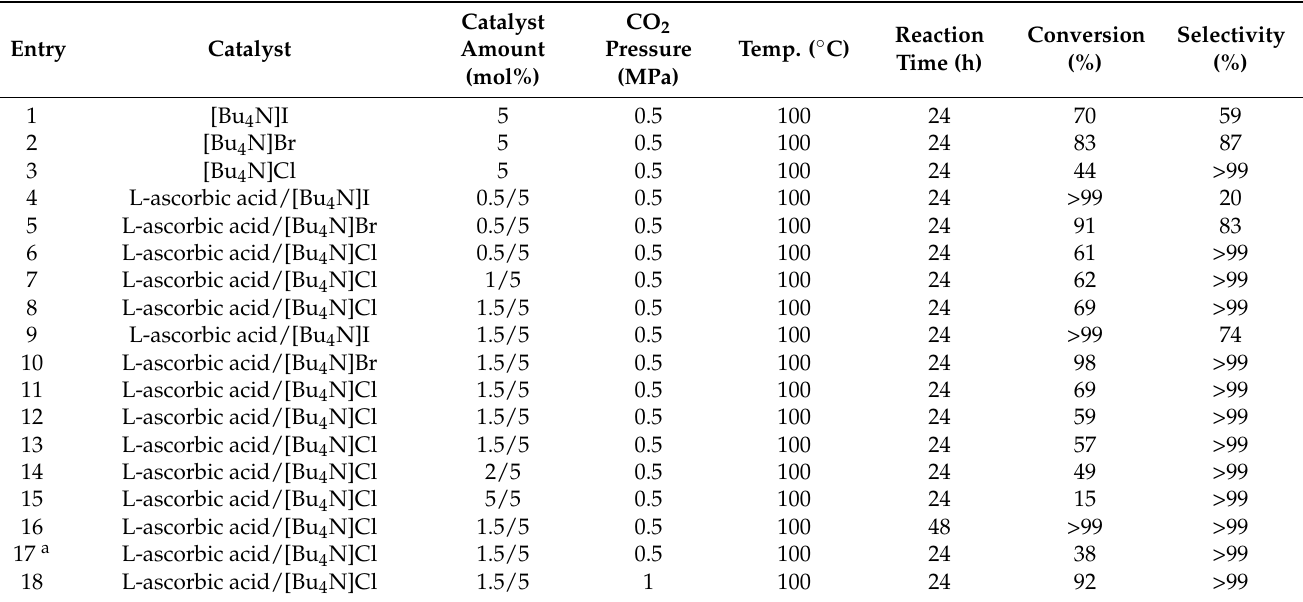
Table 21. Carbonation of methyl oleate using ascorbic acid (HBD) and different sources of